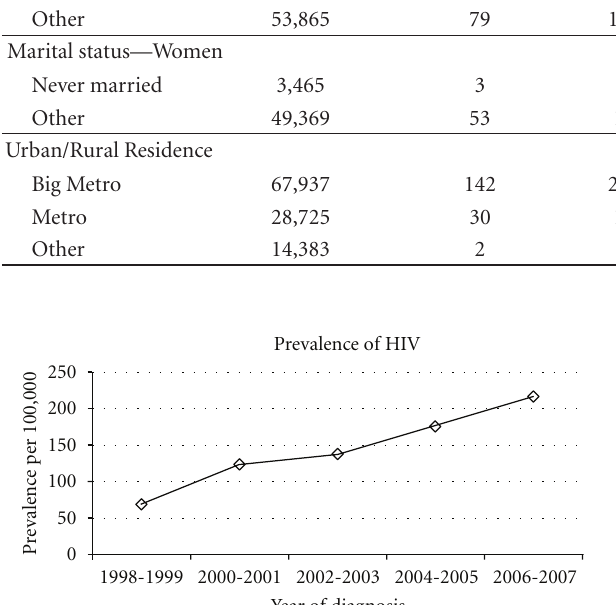
Figure 1: Prevalence of HIV over time among Medicare benefi- ciaries diagnosed with nonsmall cell lung cancer from the SEER- Medicare database.